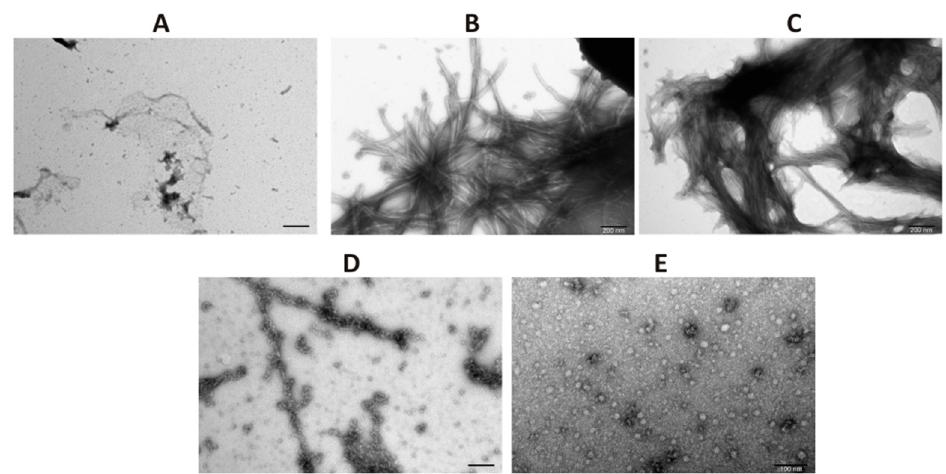
Figure 4. Influence of CacyBP / SIP on α -synuclein aggregation assessed by transmission electron microscopy (TEM). Representative micrographs of α -synuclein obtained before initiation of